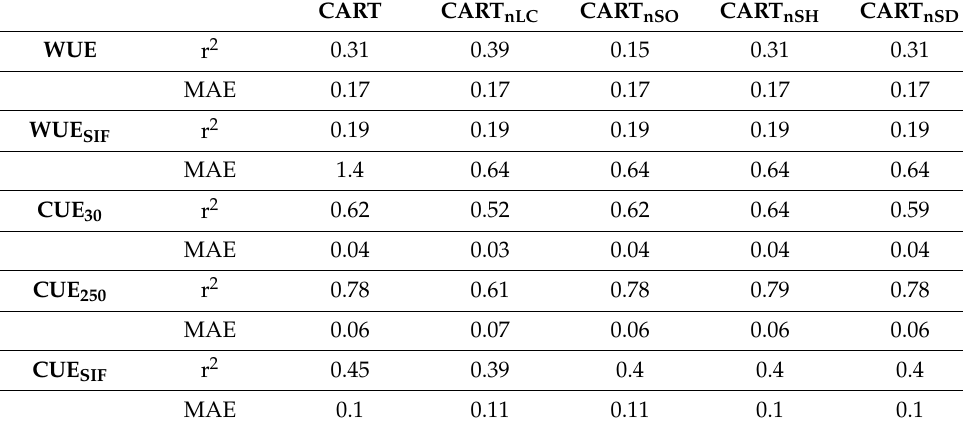
Table 3. Summary of CART r 2 and MAE (gC/KgH 2 O for WUE) for the CART models. The models with the highest r 2 and lowest MAE are highlighted in bold. CART = all soil variables used; CART nLC = land cover excluded from the analysis; CART nSO = soil order excluded from the analysis; CART nSH = soil horizon excluded from the analysis; CART nSD = soil depth excluded from the